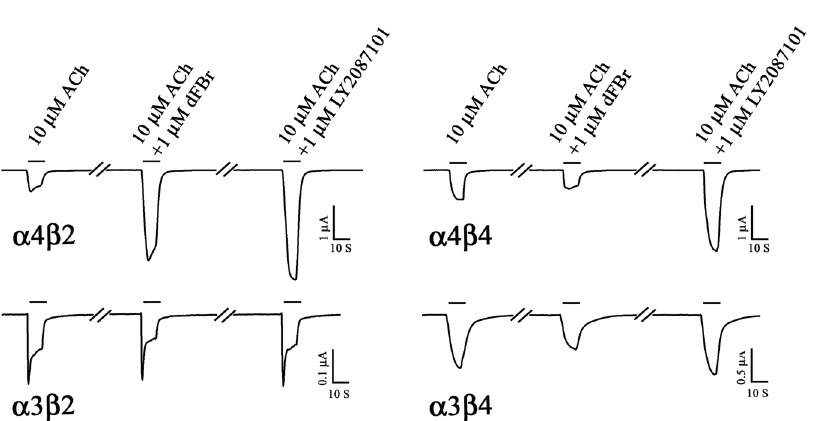
Figure 4. LY2087101 potentiation of α 4 β 2 nAChR requires α 4 but not β 2 subunits. Representative two- electrode voltage clamp traces showing the effect of LY2087101 or dFBr at 1 μ M on ACh-induced current responses of Xenopus oocytes expressing α 4 β 2, α 4 β 4, α 3 β 2, or α 3 β 4